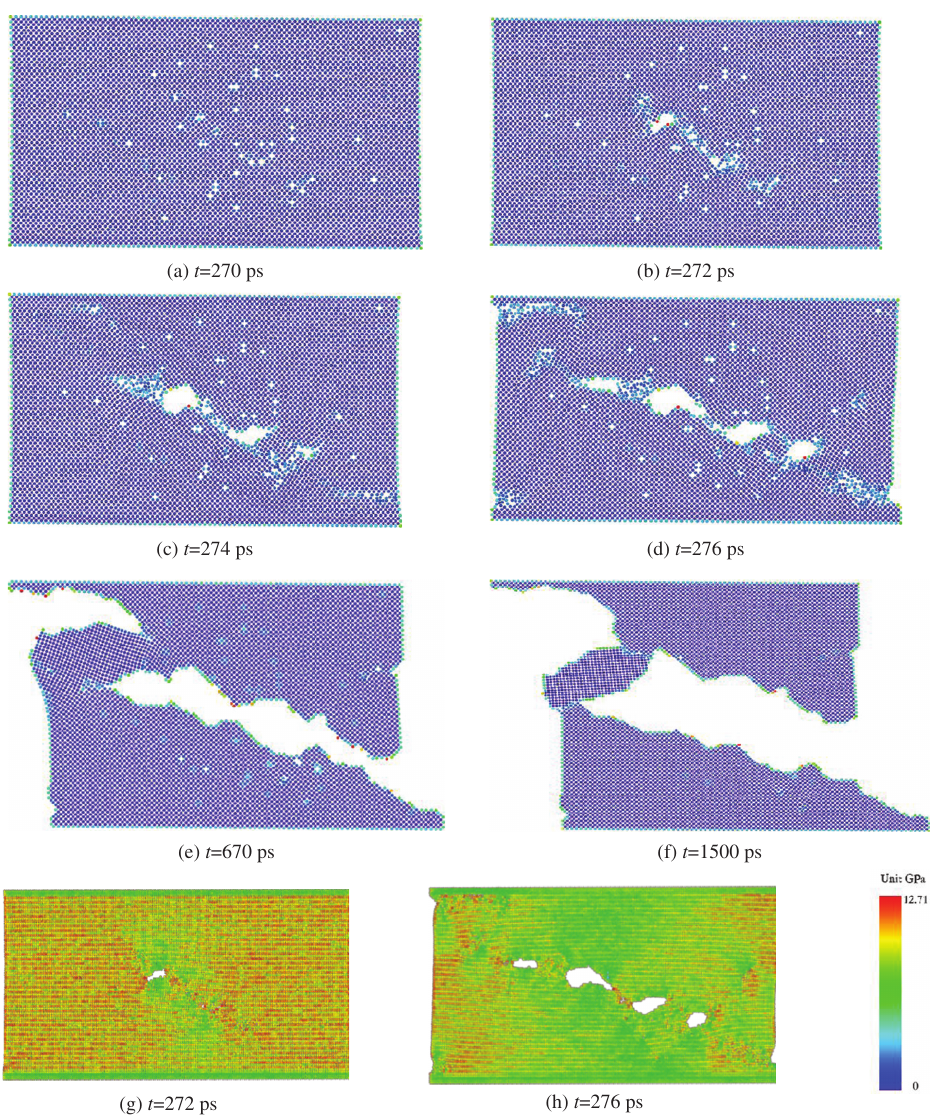
Figure 3: Atomic trajectory at different times at 300 K. Note: Dark blue represents perfect atom while light blue are defect atoms from Figure 3 (a) to (f), the color scale employed corresponds to stress is increasing from blue, the weakest, to red, the